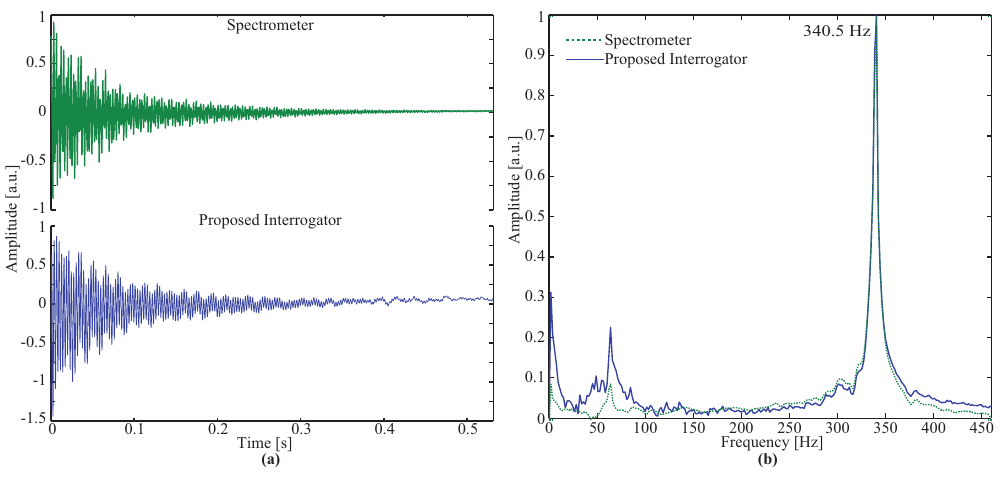
Figure 3. Natural response of the optical accelerometer: ( a ) Time domain response; ( b ) Frequency domain